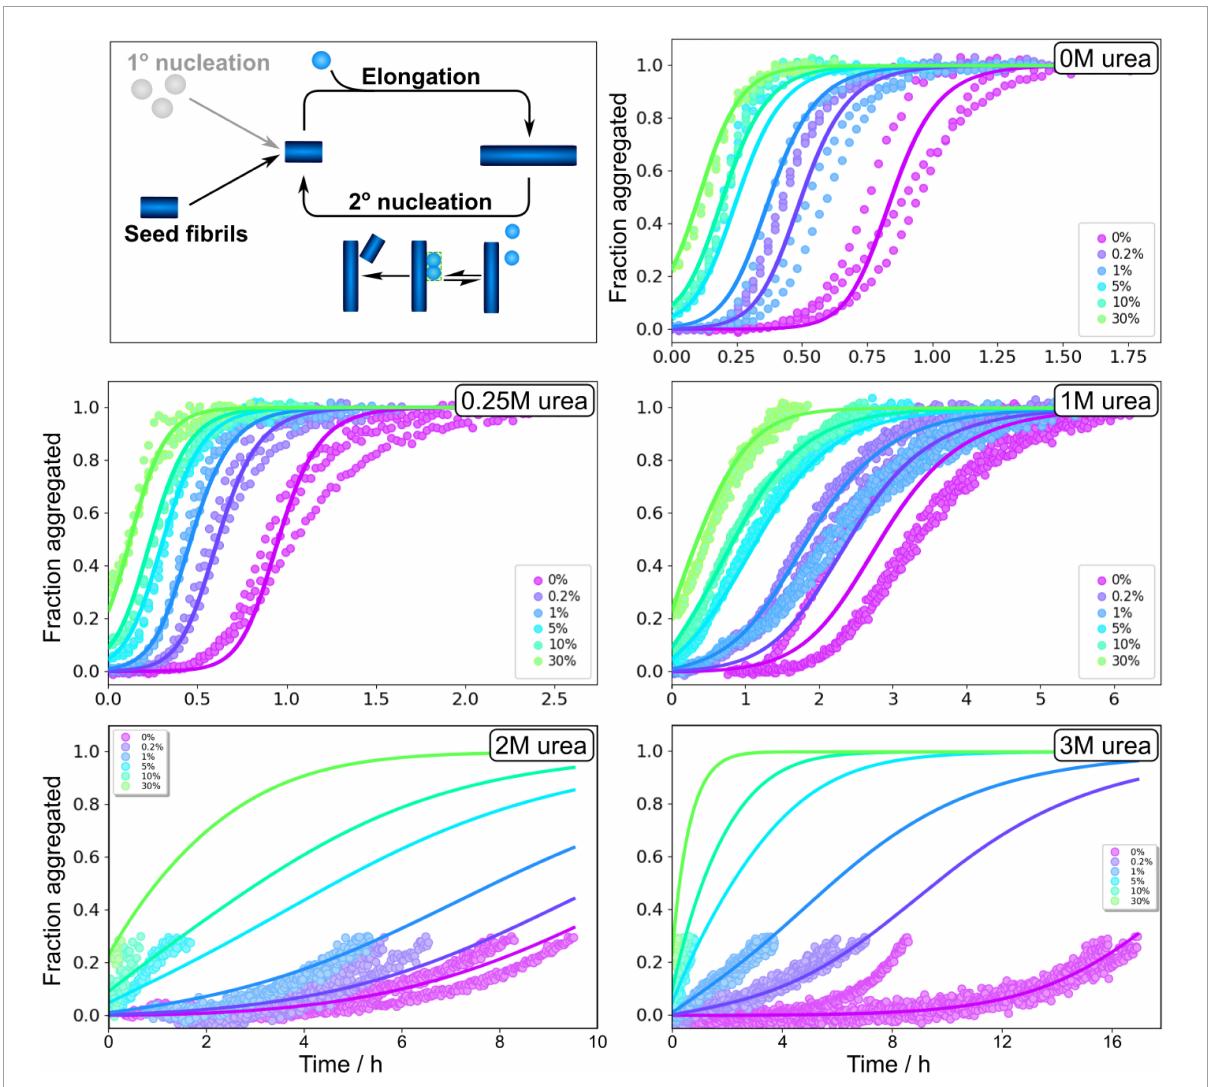
FIGURE5 Seeding experiments in urea. Normalised ThT fluorescence as a function of time for 3 µ M A β 42 in buffer with no urea, 0.25 M urea, 1 M urea, 2 M urea, and 3 M urea in 20 mM sodium phosphate, 0.2 mM EDTA, 0.02% sodium azide, pH 8.0. Seeds, prepared at the corresponding urea concentration, were added at time zero at concentrations of 0.2, 1, 5, 10, and 30% in monomer equivalents. In the presence of a secondary nucleation step, small seed concentrations allow one to bypass the primary nucleation step. The solid lines show fits to the data using the same model as for the unseeded data with n 2 , n c and K M , were fixed to the values determined in the unseeded conditions, whereas k n , k + and k 2 were globally fitted over the six seed